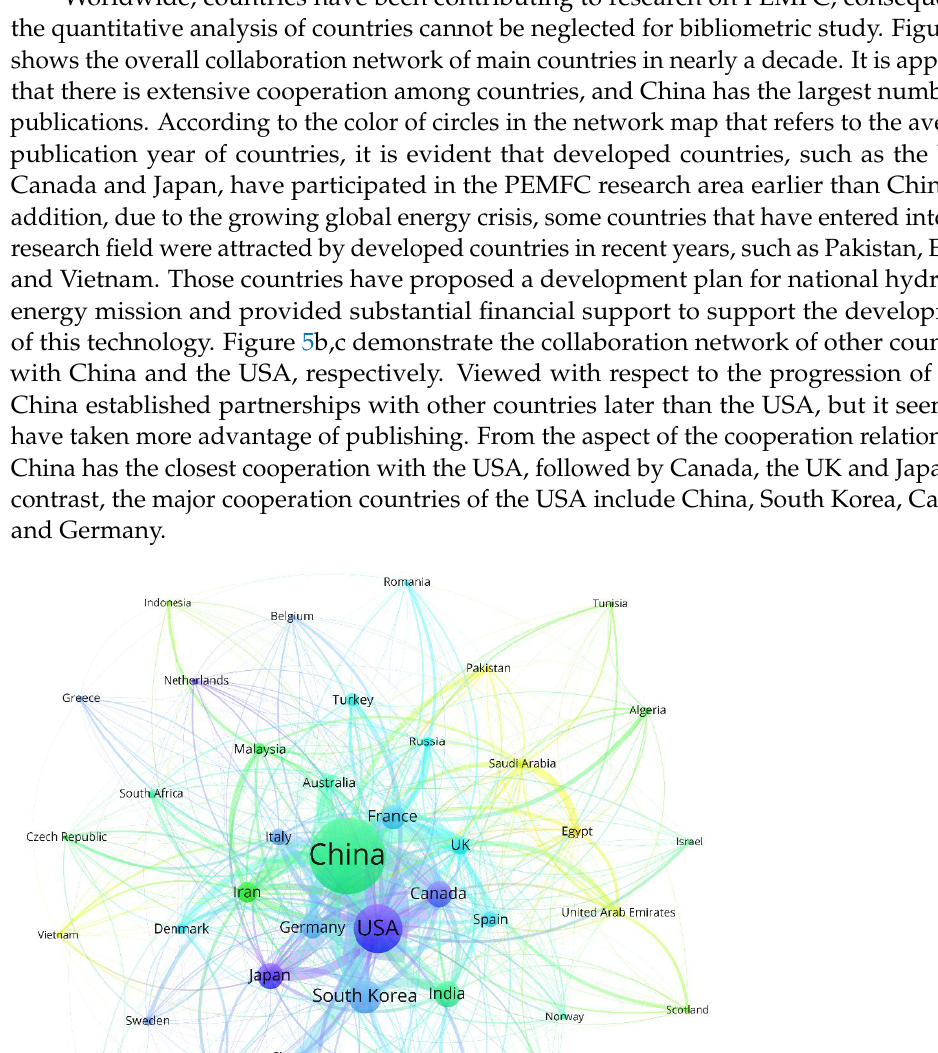
( c ) Figure 5. Collaboration network of main countries ( a ) overall collaboration network ( b ) collabora- tion network with China ( c ) collaboration network with USA. Table 4 shows the number of publications, average citations (AC), average publica- tion year (APY) and total link strength (TLS) of the top 10 countries. The above parameters